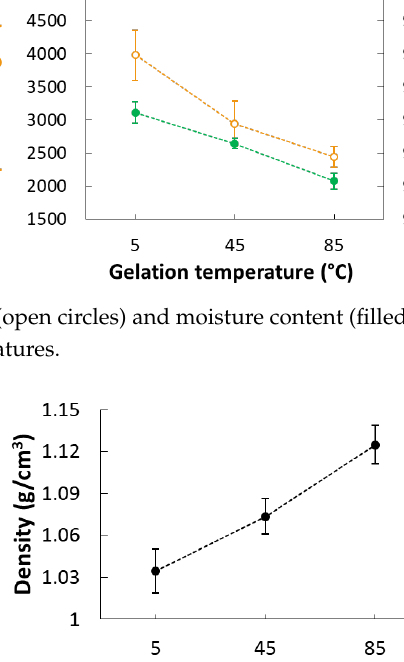
Figure 5. Visual appearance and low-vacuum scanning electron microscope (LV-SEM) images of CAG beads prepared at different gelation temperatures.